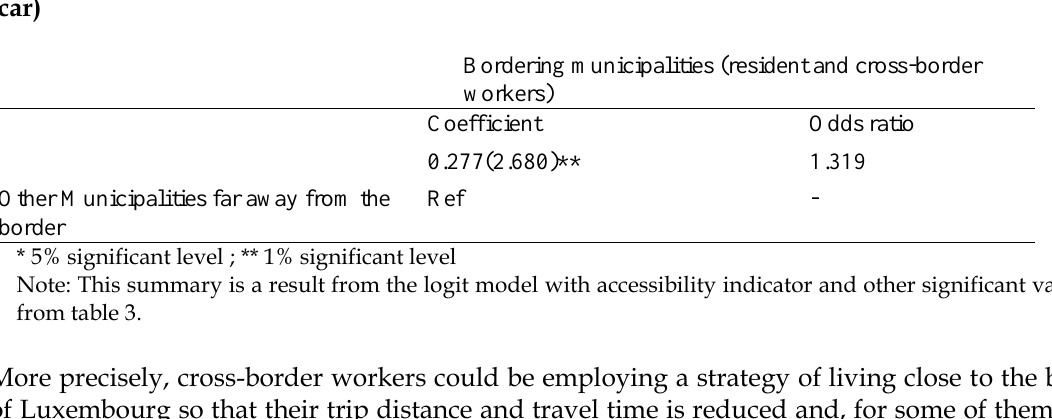
Table 3. Model 2a. Living in a bordering municipality: results for unsustainable travel mode (car)